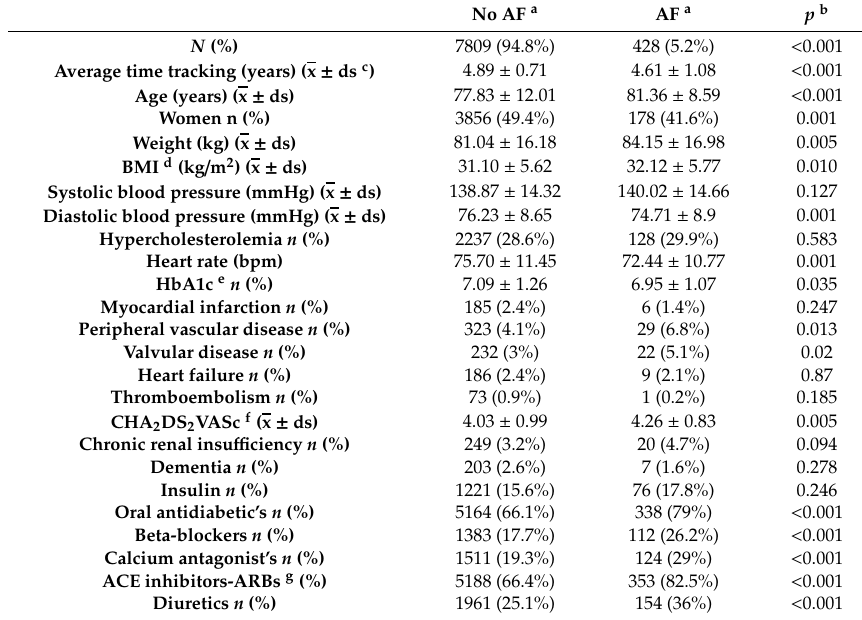
Table 1. Baseline characteristics with / without atrial fibrillation (AF).